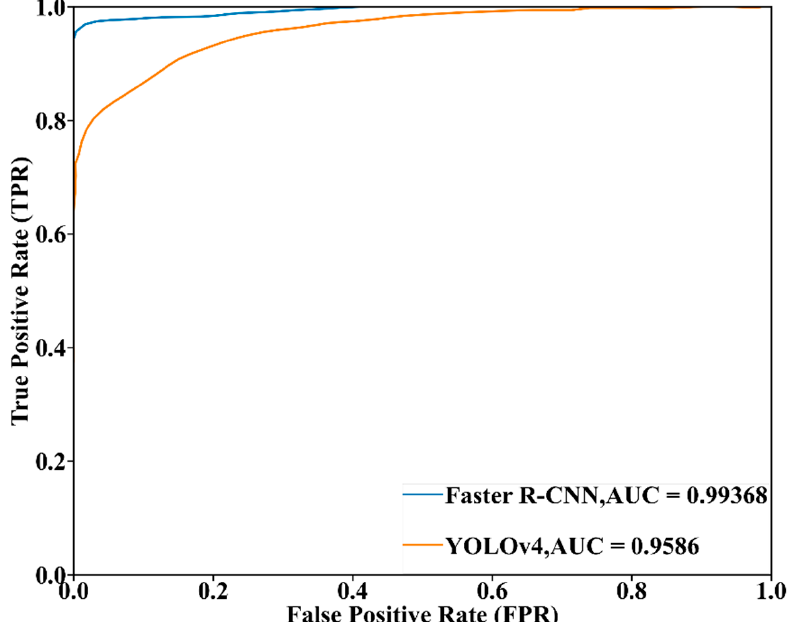
Figure 16. Confusion matrixes of the Faster R-CNN model by the experimental dataset with image size 1280 × 720 and noise intensity 0 under different pre-determined thresholds.